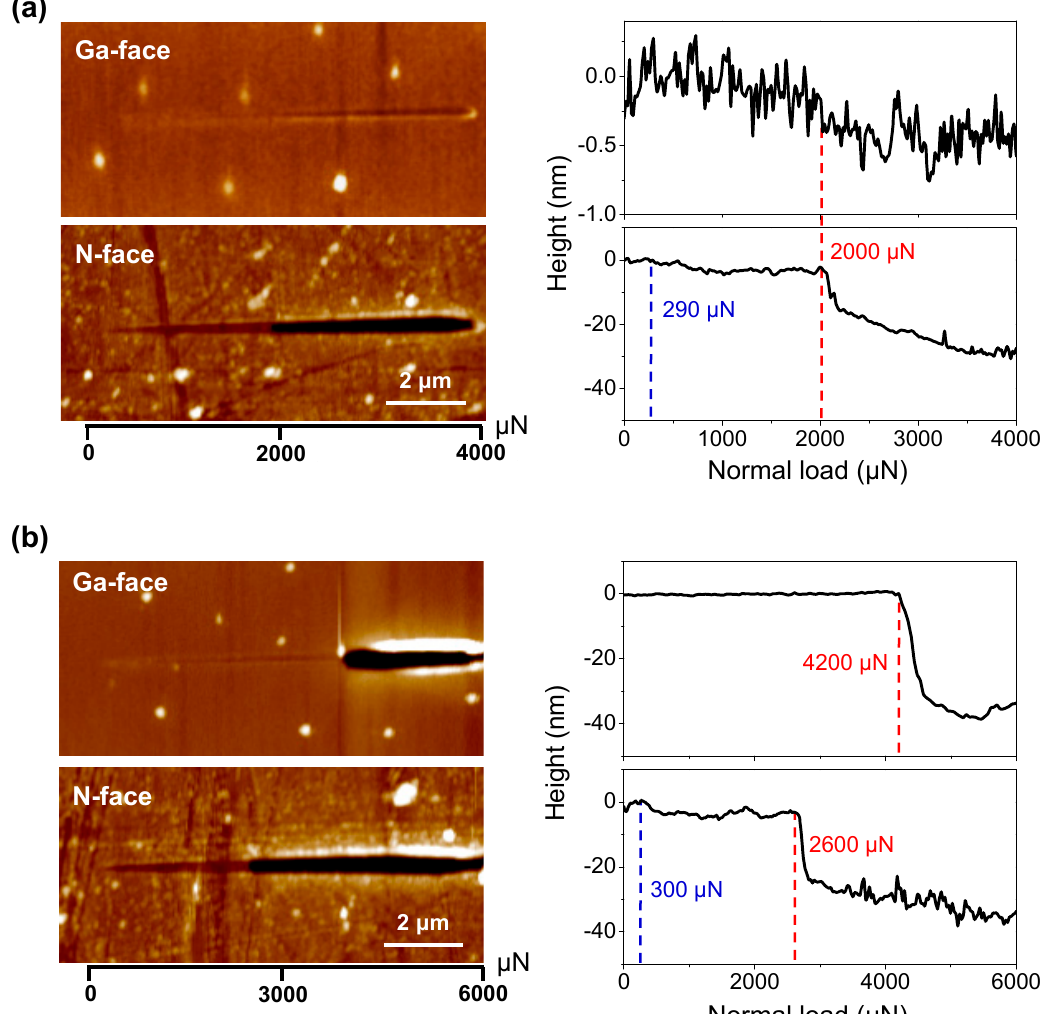
Figure 4. Nanoscratch tests on Ga- and N-faced GaN samples under the progressive normal load. ( a ) The progressive normal load ranged from 0 to 4000 µ N. ( b ) The progressive normal load ranged from 0 to 6000 µ N. The left AFM images show the morphology of the scratches and the right curves show the depth of scratch-induced groove with respect to the normal load. The scratching distance was 10 µ m.